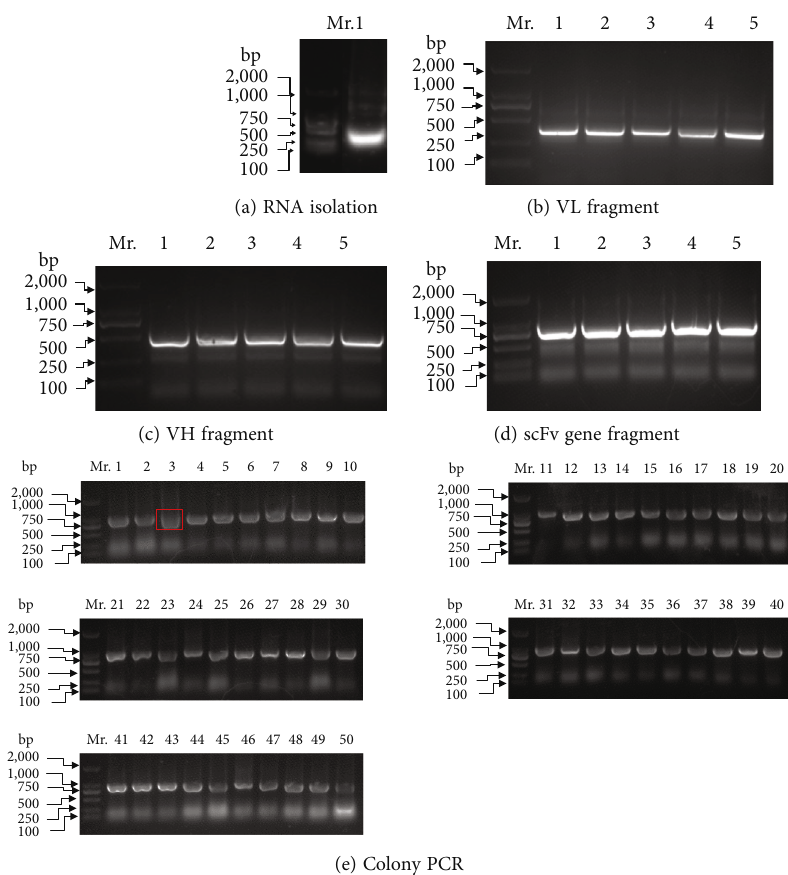
Figure 3: Summary of the construction of hTK1-IgY-scFv phage antibody libraries from immunized hens: (a) agarose gel electrophoresis detected the isolated RNA; (b) the antibody VL fragment was obtained by RT-PCR; (c) the VH fragment of the antibody was obtained by RT-PCR; (d) the scFv gene fragment was obtained by overlap PCR; (e) colony PCR was performed on 50 random clones in a total of 340 clones. A negative clone was detected (#3 in red box). Lane Mr. DNA marker: DNA 2000, 1000, 750, 500, 250, and 100